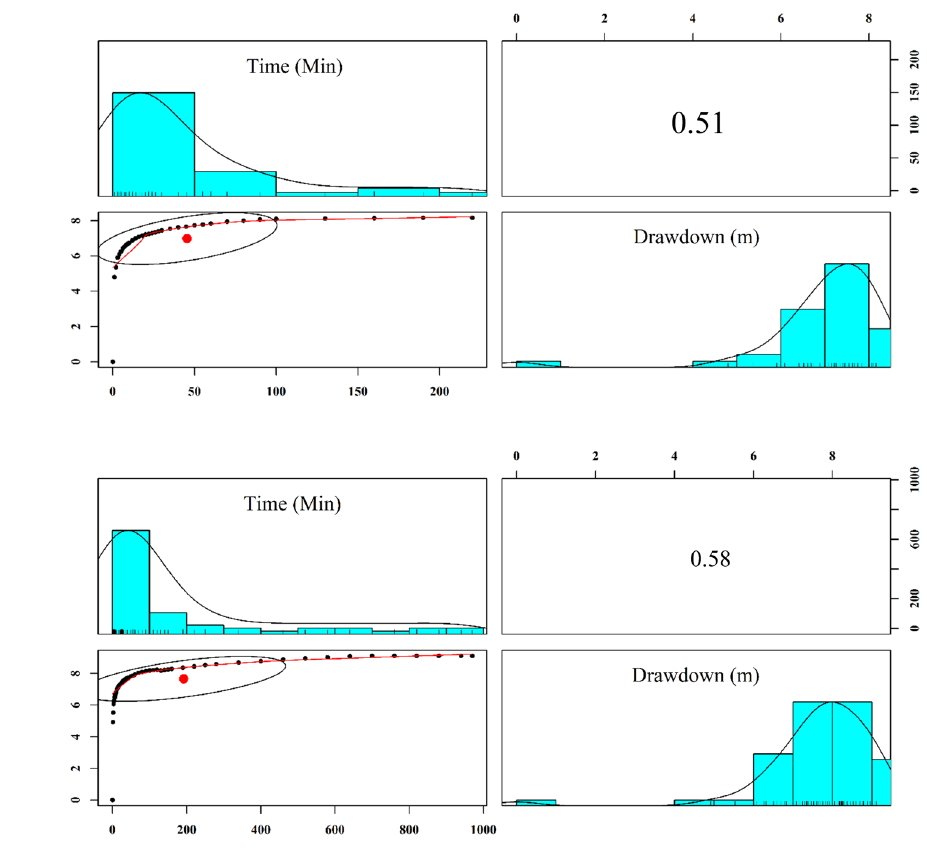
Table 2 Results of marginal distributions of values of groundwater drawdown and pumping time with a discharge of 26.64